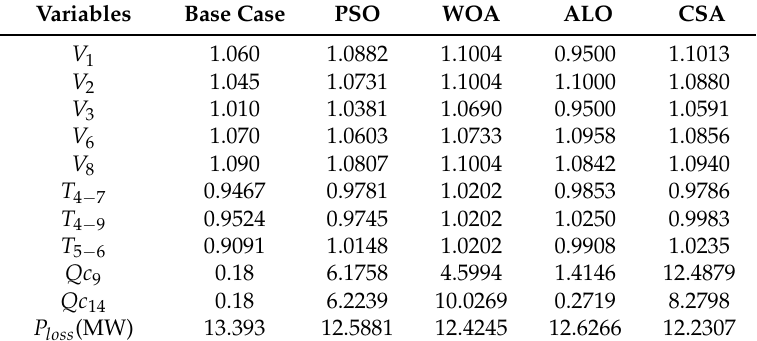
Table 3. Comparison of simulation results for IEEE 14-bus test using various approaches.